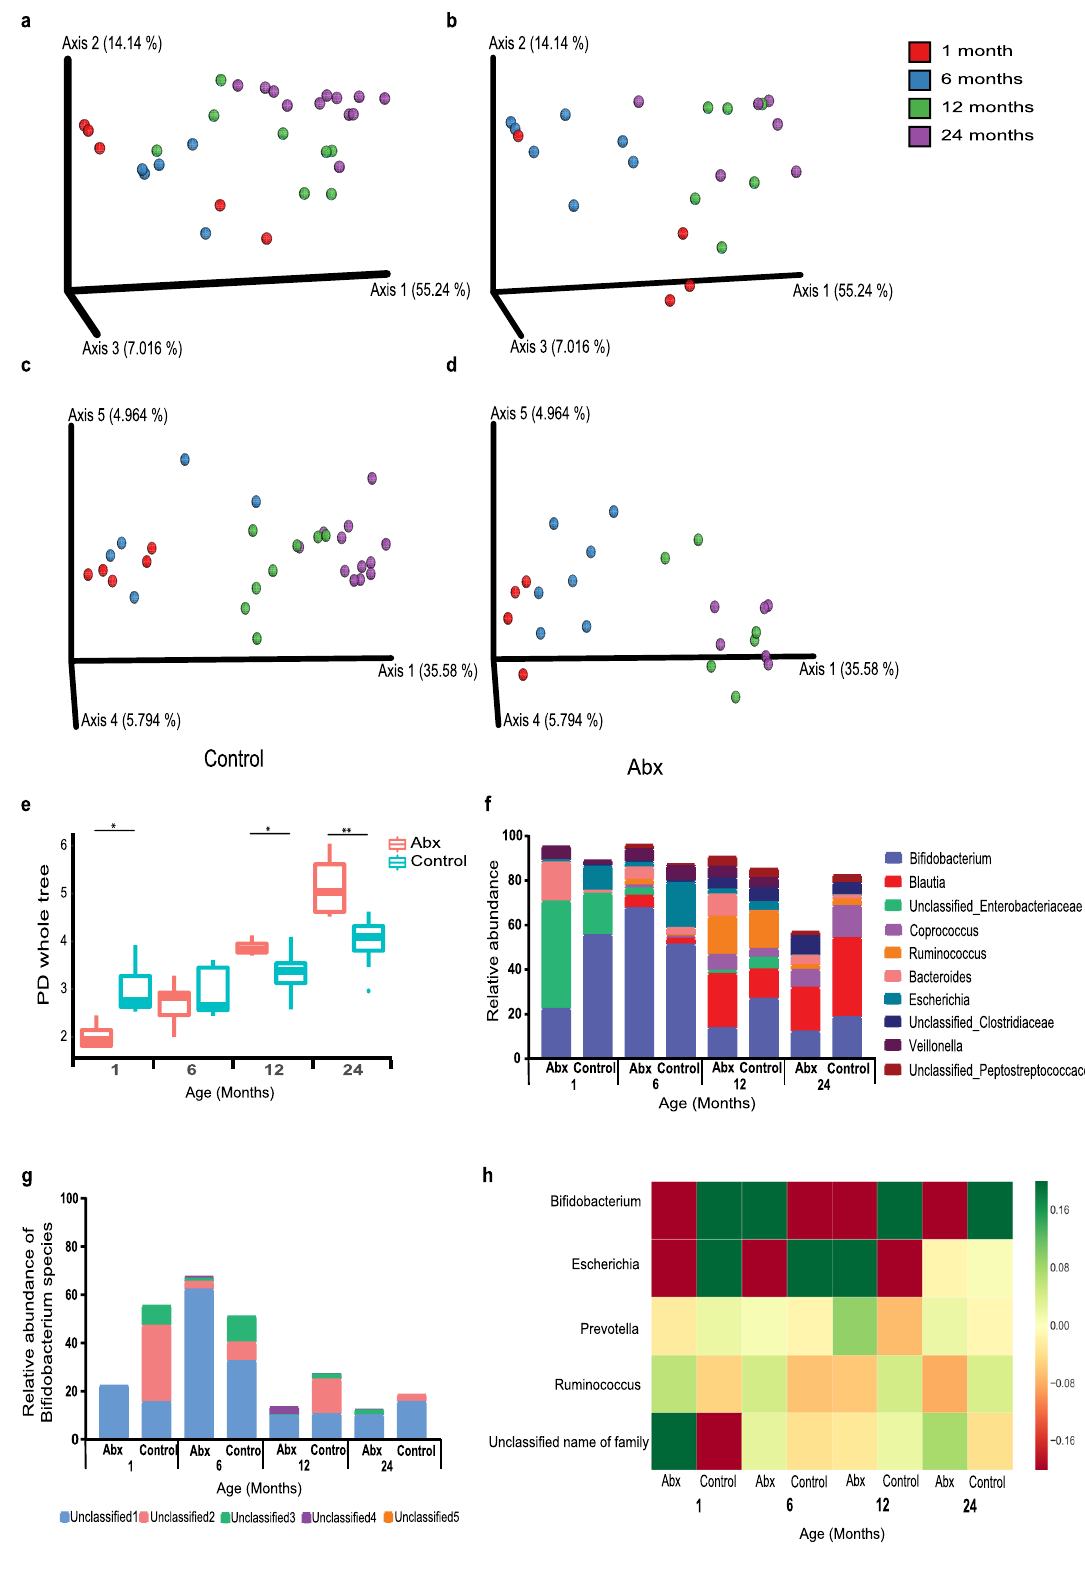
(Supplementary Table 7). At the age of one month, when all of the infants were breastfed, Bi fi dobacterium species were detected almost exclusively in the control group (13 species/ n = 7, compared to one species in the antibiotics group, n = 5, p -value = 5.3 × 10 − 4 ). The differences in presence were most notable for B. bi fi dum (4/7 in the control group, 0/5 in